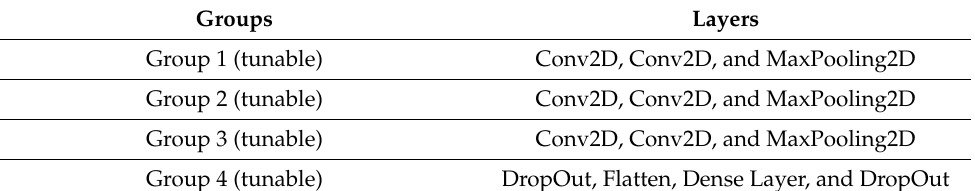
Table 4. General CNN model structure.